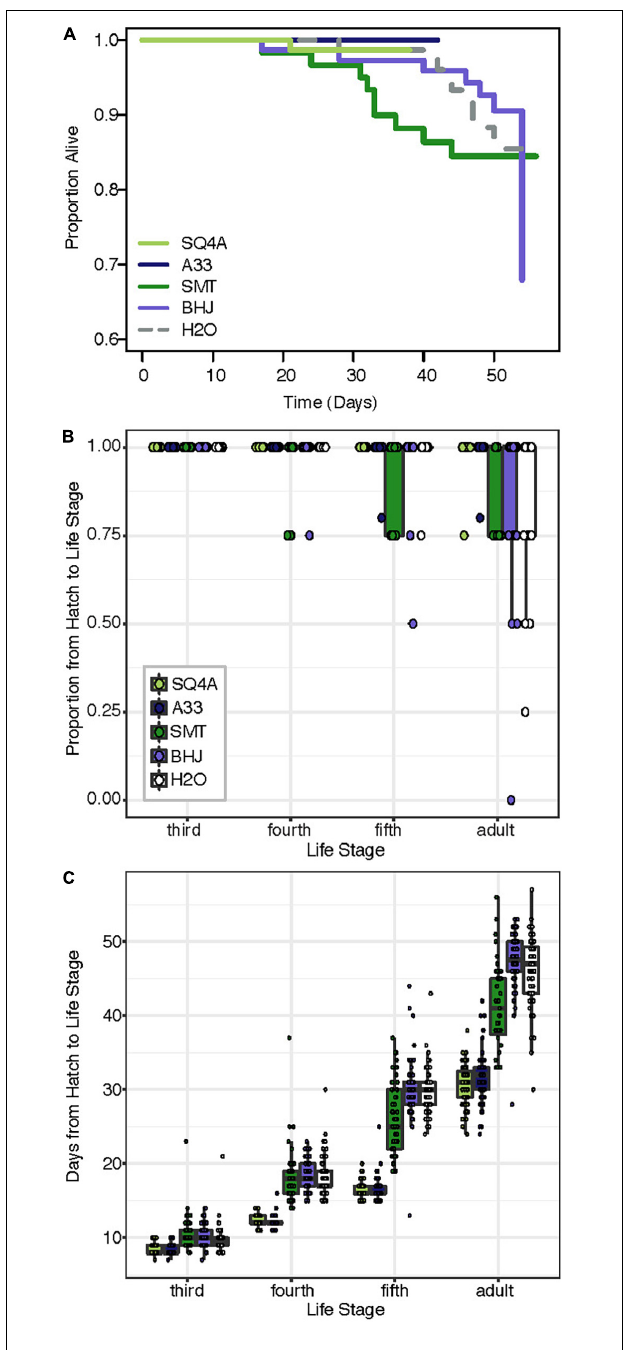
FIGURE 8 | Bacterial strains provide different levels of fitness benefit. Squash bugs were fed either one of two strains of Caballeronia (SQ4a, A33), a strain of Paraburkholderia (SMT), a strain of Cupriavidus (BHJ), or water (H2O) as an un-inoculated control; n = 60–76 per treatment. (A) Kaplan-Meier survival curves for bacteria-inoculated (solid lines) and un-inoculated (dashed) treatments. Data is censored at the time individuals reached adulthood. (B) Proportion of individuals in each box surviving from hatch to each subsequent life stage. Proportions for each box are overlaid on box-whisker plots. (C) Development time from hatch to each instar (legend in panel B ). Points, overlaid on box-whisker plots, indicate estimated development time for each individual that made it to that life